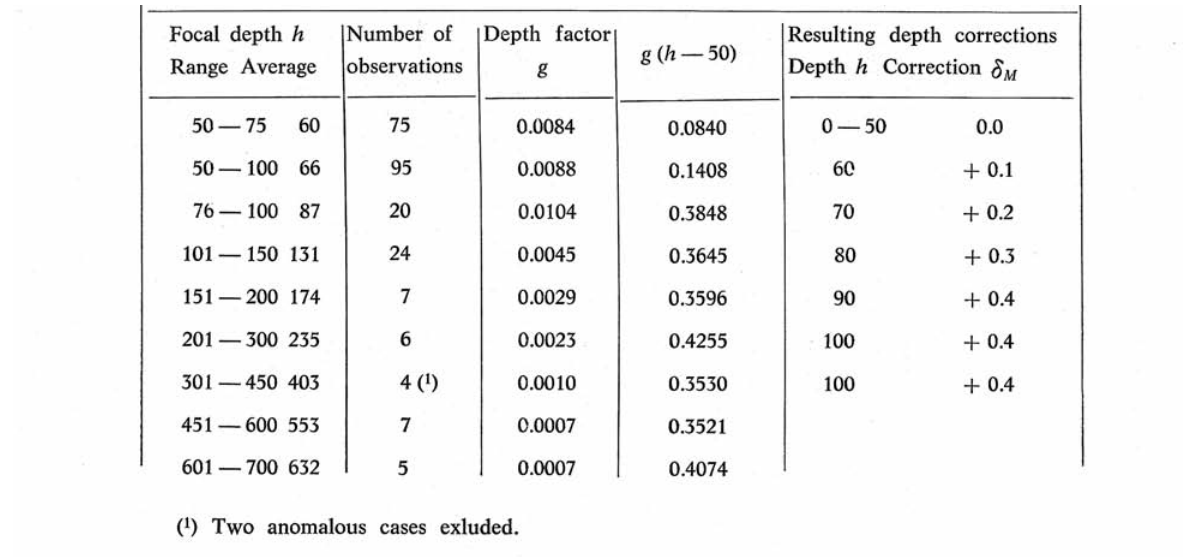
Table 4. Depth dependence of surface-wave magnitudes M